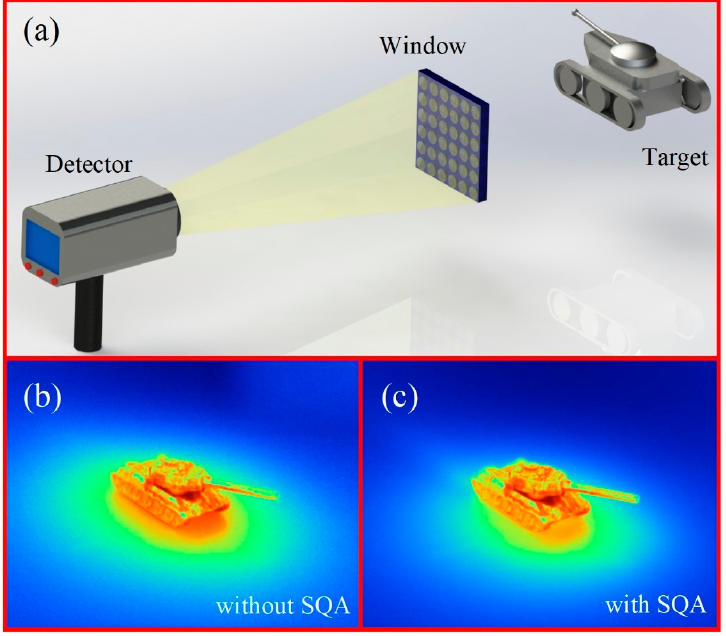
Figure 5. ( a ) Schematic diagram of the self-built infrared detection system consisting of target, infrared window, and infrared detector: the measured target images at temperature of 303 K through infrared window without ( b ) and with ( c ) SQA. Table 1. Mean pixel contrast index of SQA and ASS.